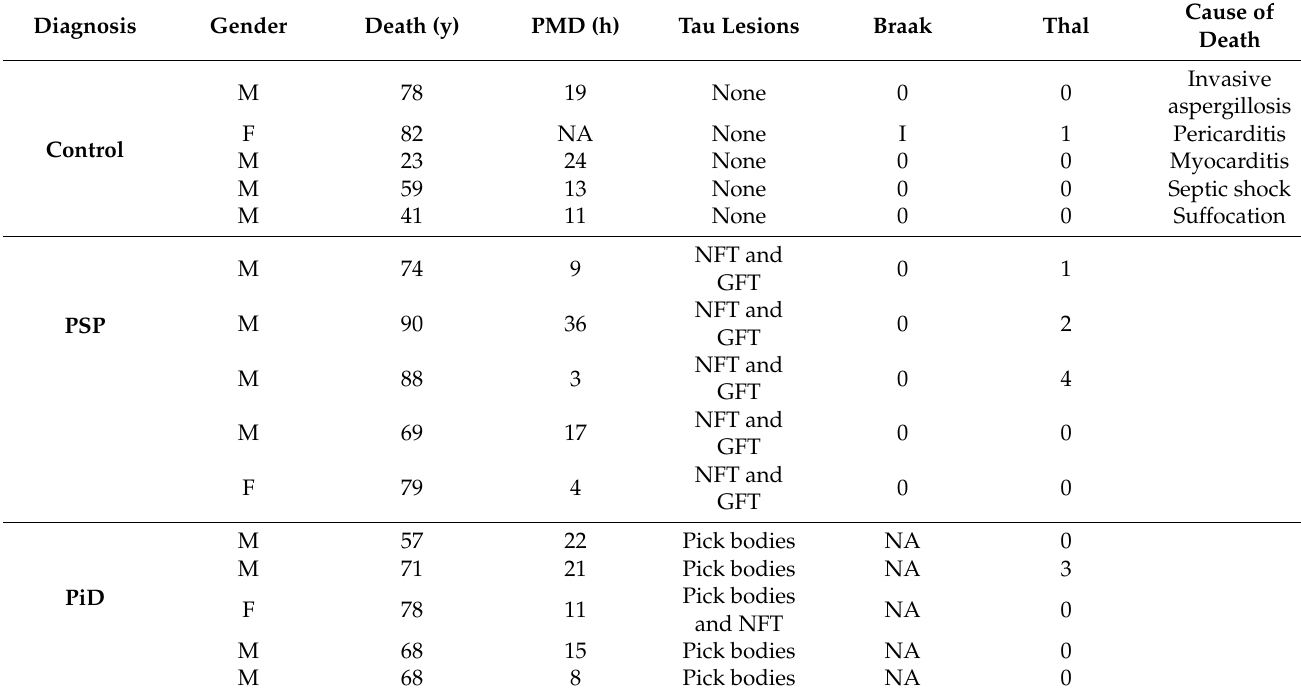
Table 1. Demographic, biological, and clinical characteristics of the brain sample donors. The characteristics of the donors who provided brain samples used for BDF isolation are listed ( n = 5 non-demented control subjects, n = 5 PSP patients, and n = 5 PiD patients). PMD, postmortem delay; NFTs, neurofibrillary tangles; GFTs, glial fibrillary tangles; NA, not applicable. Braak and Thal stages are the two hallmarks of Alzheimer’s disease. These stages are used here to categorize NFT or amyloid β peptide (A β ) deposition, respectively, and are classified in stages I to VI for NFT [25] and 1 to 5 for A β deposits